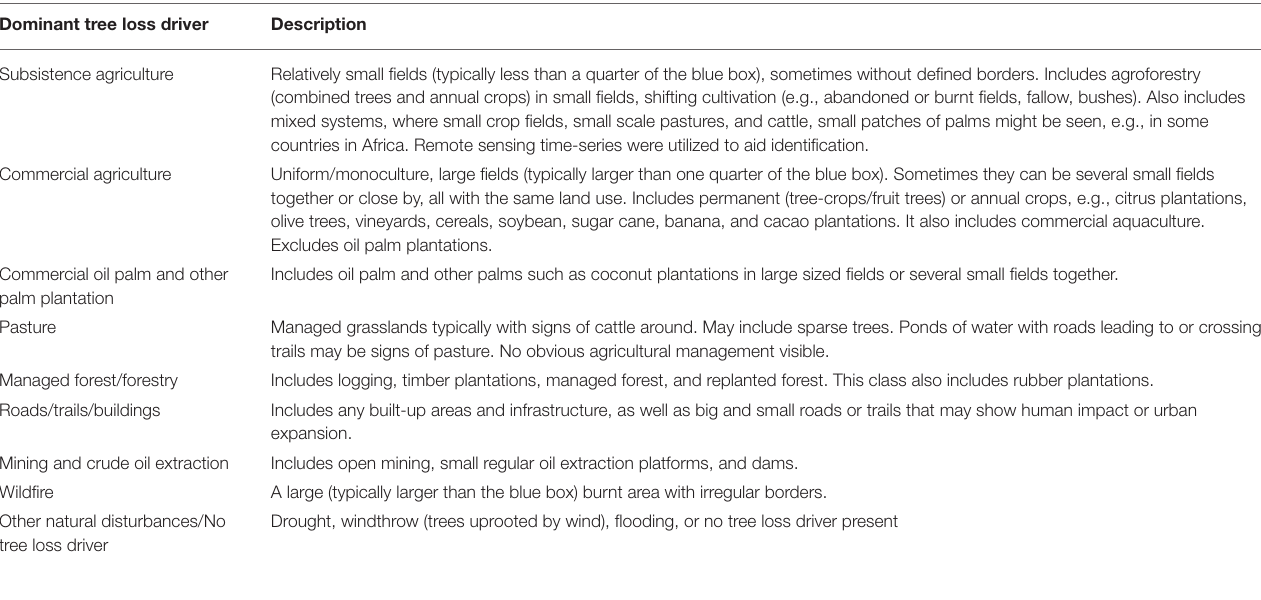
TABLE 1 | The dominant tree loss drivers in the Geo-Wiki “Drivers of Tropical Forest Loss” crowdsourcing campaign. Dominant tree loss